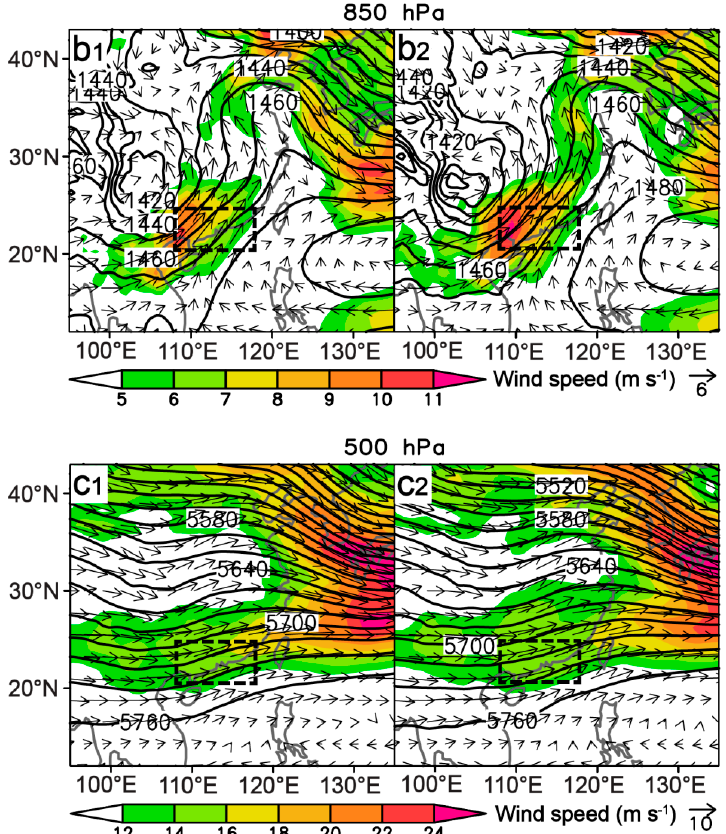
Figure 3. Composite ( a 1 – a 2 ) mean-sea-level pressures (color-shaded; units: hPa) and wind vectors (units: m s − 1 ), and ( b 1 – b 2 ) 850-hPa and ( c 1 – c 2 ) 500-hPa geopotential heights (contours; units: gpm) and winds (color-shaded: wind speeds; vectors: wind vectors; units: m s − 1 ) before ( a 1 , b 1 , c 1 ) and after ( a 2 , b 2 , c 2 ) MCSs turned to move southeastward. The solid rectangles indicate the location of the provinces of Guangdong and Guangxi.